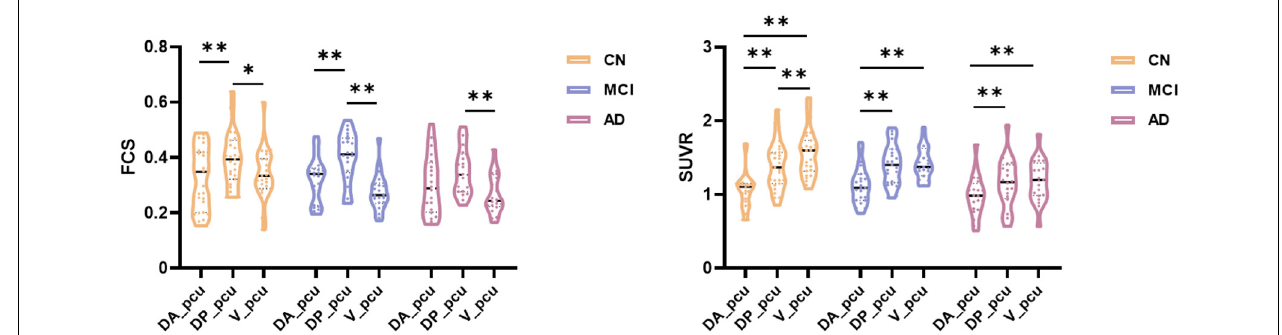
FIGURE 5 | Subregional dedifferentiation of the FCS and SUVR in MCI and AD. For FCS, the significant difference between DP_pcu and DA_pcu that existed in CN and MCI groups disappeared in the AD group. For SUVR, the significant difference between DP_pcu and V_pcu that existed in the CN subjects decayed in both MCI and AD patients. Additionally, the overall analysis of variance (ANOVA) test yielded an insignificant main effect of subregion for the SUVR in the AD patients ( p = 0.087). Subregional differences were compared via ANOVA with post hoc paired t -tests and Bonferroni corrections. ∗ p < 0.05, uncorrected; ∗∗ p < 0.05, Bonferroni corrected. Abbreviations: FSC, functional connectivity strength; SUVR, standard uptake value ratio; CN, cognitively normal; MCI, mild cognitive impairment; AD, Alzheimer’s Disease; V_pcu, ventral precuneus; DP_pcu, dorsal posterior precuneus; DA_pcu, dorsal anterior precuneus; ANOVA, analysis of